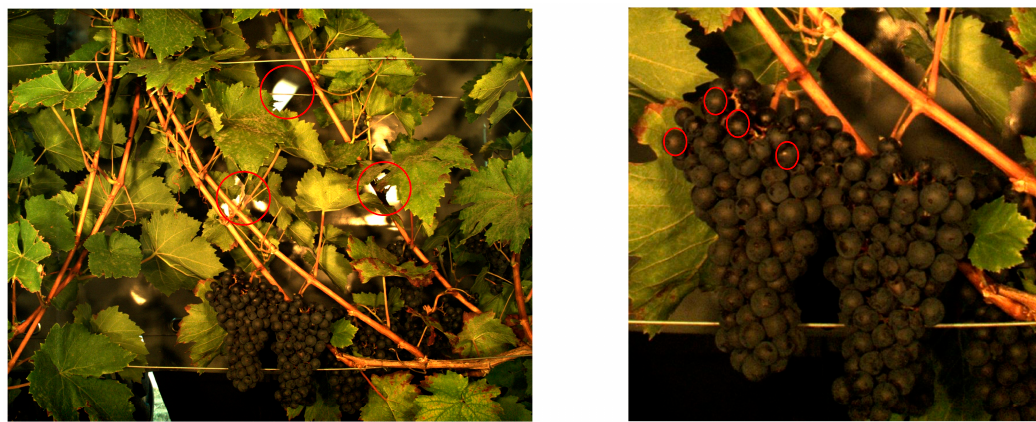
Figure 11. High intensity reflections result in a wrong point positions at object borders (left image). At berry arches, they may corrupt the spherical geometry of the berries during